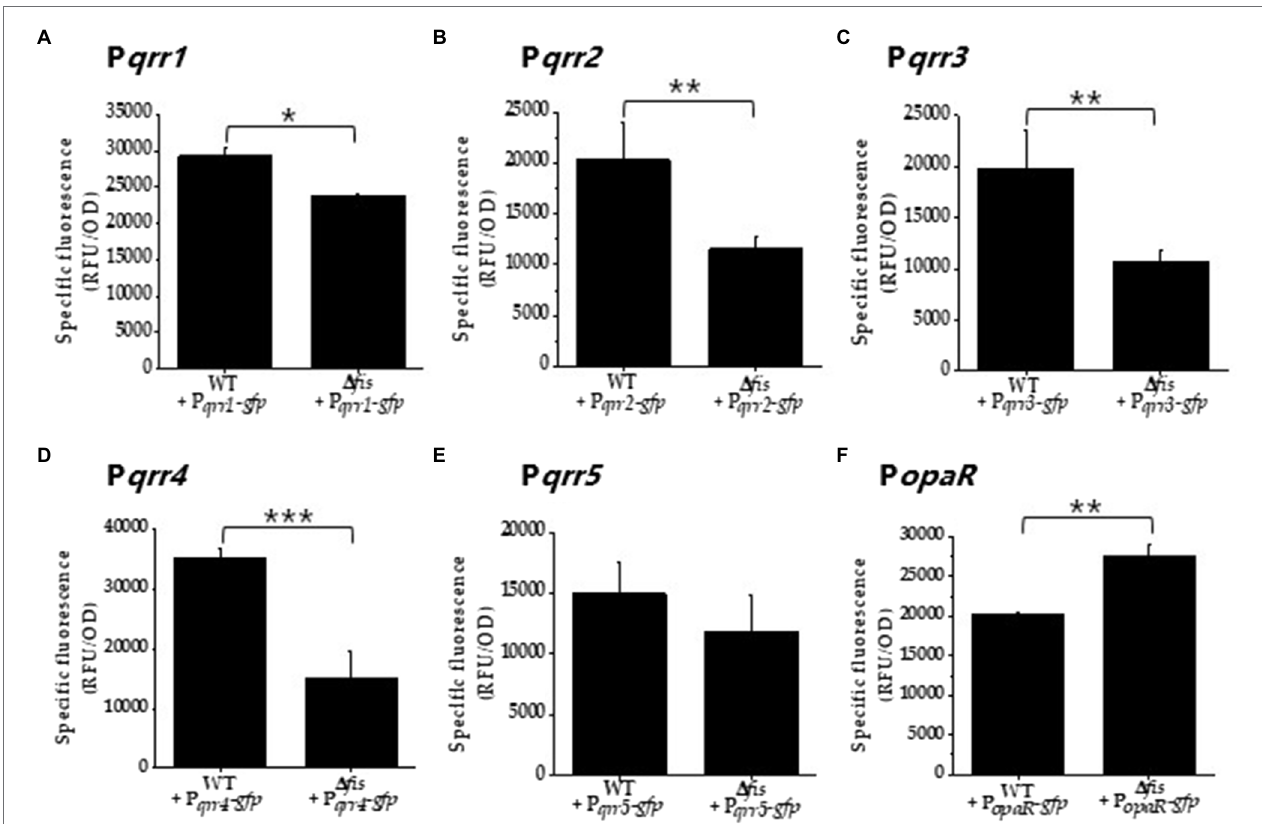
FIGURE 2 | Fis is a positive regulator of the qrr genes. (A) P qrr1 , (B) P qrr2 , (C) P qrr3 , (D) P qrr4 , (E) P qrr5 , and (F) P opaR green fluorescent protein (GFP) transcriptional reporter assays in wild type and the Δ fis mutant in cultures grown to OD 0.4–0.45 and measured for specific fluorescence (RFU/OD). Means and standard deviations of three biological replicates are plotted. Statistics calculated using a Student’s t -test (* p < 0.05, ** p < 0.01, *** p <